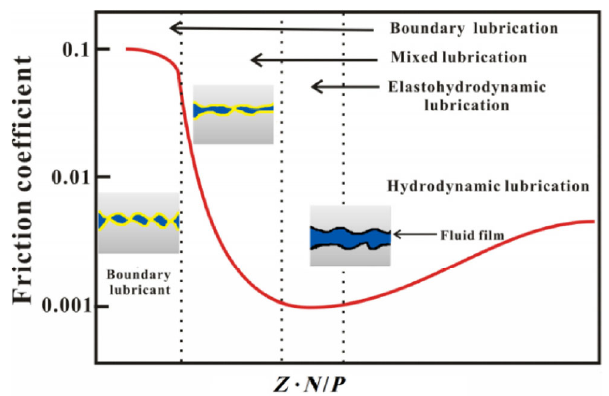
Fig. 1 Stribeck curve during liquid lubrication.